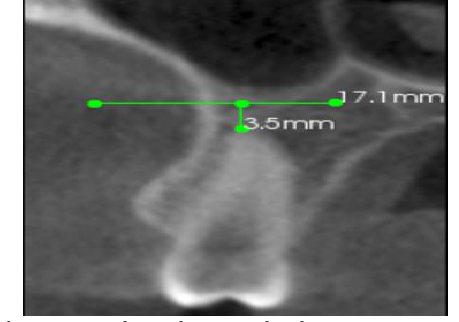
Figure 1: When the root had no contact with sinus floor, the distance was recorded as a positive value